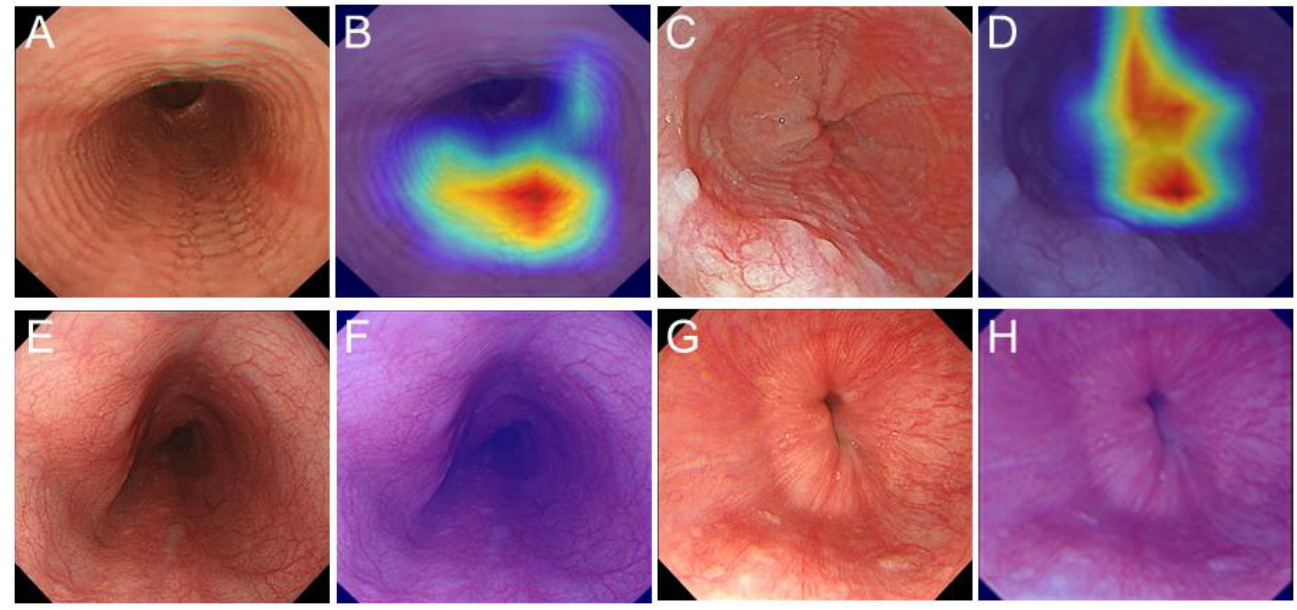
Figure 2. Representative cases of correct EoE detection with artificial intelligence (AI)-based diag- nosis system. ( A ) Case of EoE showing edema, linear furrows, and rings in the middle esophagus. ( B) Images overlaid with relevance heatmaps (probability score; 1). ( C ) Case of EoE showing linear furrows and whitish exudates in the lower esophagus. ( D ) Images overlaid with relevance heatmaps (probability score; 1). ( E , G ) Subject with normal esophagus. ( F , H ) Images overlaid with relevance heatmaps (probability score; <0.01).